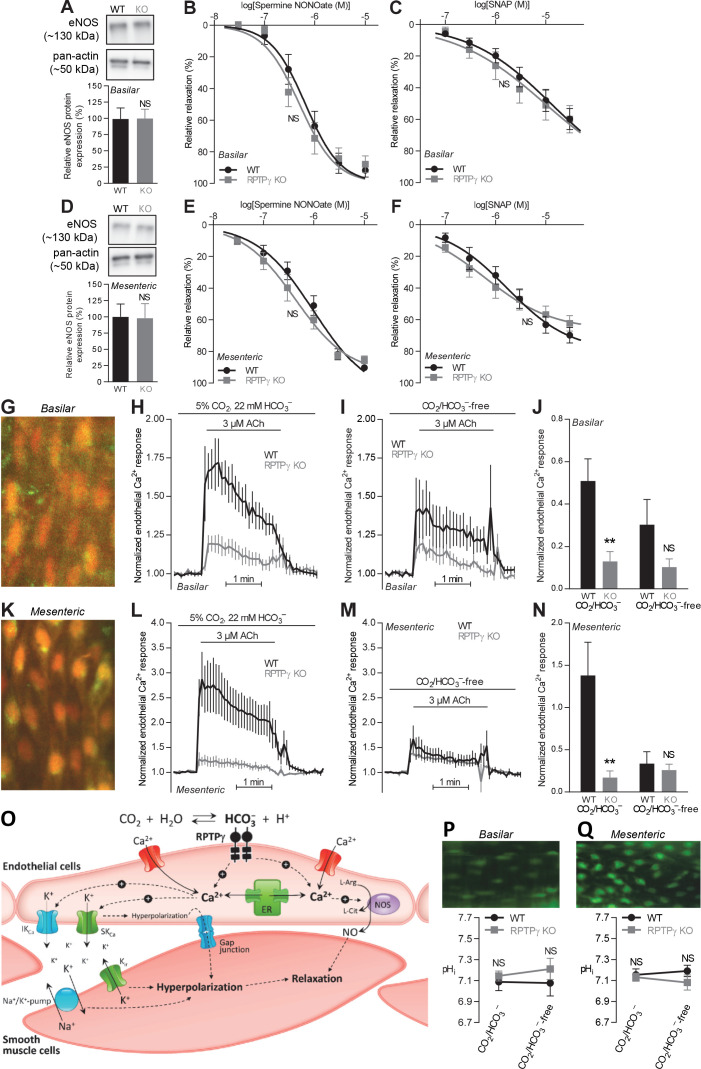
Acetylcholine (ACh)-induced endothelial intracellular Ca2+ responses are lower in arteries from RPTPγ KO than WT mice.In contrast, expression of endothelial NO-synthase (eNOS), responses to NO-donors, and endothelial intracellular pH are unaffected in basilar and mesenteric arteries from RPTPγ KO compared to WT mice. (A and D). Expression of eNOS in basilar (A) and mesenteric (D) arteries from RPTPγ KO and WT mice (n = 5–6). Representative bands are shown next to results from densitometric analyses where the expression levels relative to pan-actin are normalized to the average level in arteries from WT mice. (B and E) Spermine NONOate-induced relaxations of basilar (B, n = 10–14) and mesenteric (E, n = 9) arteries from RPTPγ KO and WT mice. (C and F) SNAP-induced relaxations of basilar (C, n = 10–15) and mesenteric (F, n = 9) arteries from RPTPγ KO and WT mice. All experiments in panels B, C, E, and F were performed on arteries pre-contracted with U46619, in presence of CO2/HCO3–, and after treatment with 100 µM L-NAME, 50 nM apamin, and 1.0 µM TRAM-34. (G and K) Overlaid fluorescence images of endothelial cells in basilar (G) and mesenteric (K) arteries loaded by luminal perfusion with Fluo-4 (green) and Fura Red (red). (H, I, L, and M) Average traces of acetylcholine-induced endothelial intracellular Ca2+ responses in basilar (H and I) and mesenteric (L and M) arteries from RPTPγ KO and WT mice (n = 6–9) in presence (H and L) and absence (I and M) of CO2/HCO3–. The evaluation of endothelial Ca2+ responses was based on the F505-530/F>600 ratio normalized to the average ratio during the first two minutes of the individual recordings. (J and N) Summarized endothelial intracellular Ca2+ responses in basilar (J) and mesenteric (N) arteries upon acetylcholine stimulation (n = 6–9). The endothelial Ca2+ response was calculated as the average increase in normalized fluorescence during the 2 min acetylcholine exposure compared to the baseline value before activation. (O) Schematic illustration of how RPTPγ influences vasomotor functions of resistance arteries. (P and Q) Steady-state intracellular pH of endothelial cells in basilar (P) and mesenteric (Q) arteries from RPTPγ KO and WT mice (n = 5–7) in the presence and absence of CO2/HCO3–. In panels A and D, expression levels were compared with unpaired two-tailed Student’s t-tests. In panels B, C, E, and F, the relative relaxations were fitted to sigmoidal curves and compared using extra sum-of-squares F tests. In panels J and N, data were compared by two-way ANOVA followed by Sidak’s post-tests. In panels P and Q, data were compared by repeated-measures two-way ANOVA followed by Sidak’s post-tests. The data in panel N were log-transformed before comparisons. *p<0.05, **p<0.01, ***p<0.001, NS: not significantly different vs WT. ER, endoplasmic reticulum; Kir, inward-rectifier K+-channel; IKCa, intermediate-conductance K+-channel; NOS, NO-synthase; SKCa, small-conductance K+-channel; SNAP, S-nitroso-N-acetylpenicillamine.